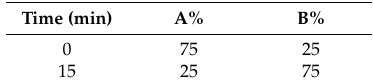
Table 4. LC-HRMS gradient